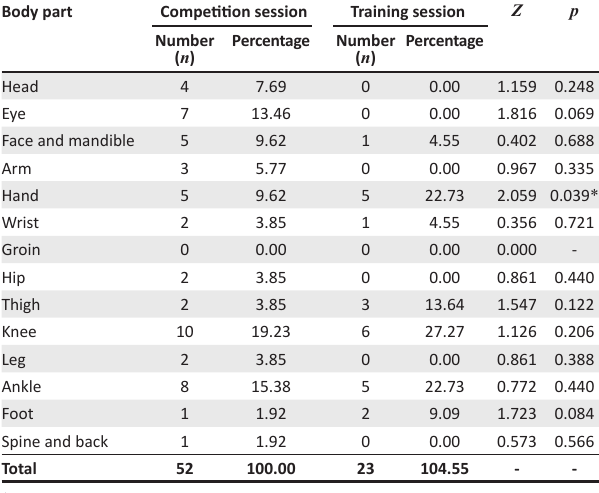
TABLE 1 : Body part injured during competition and